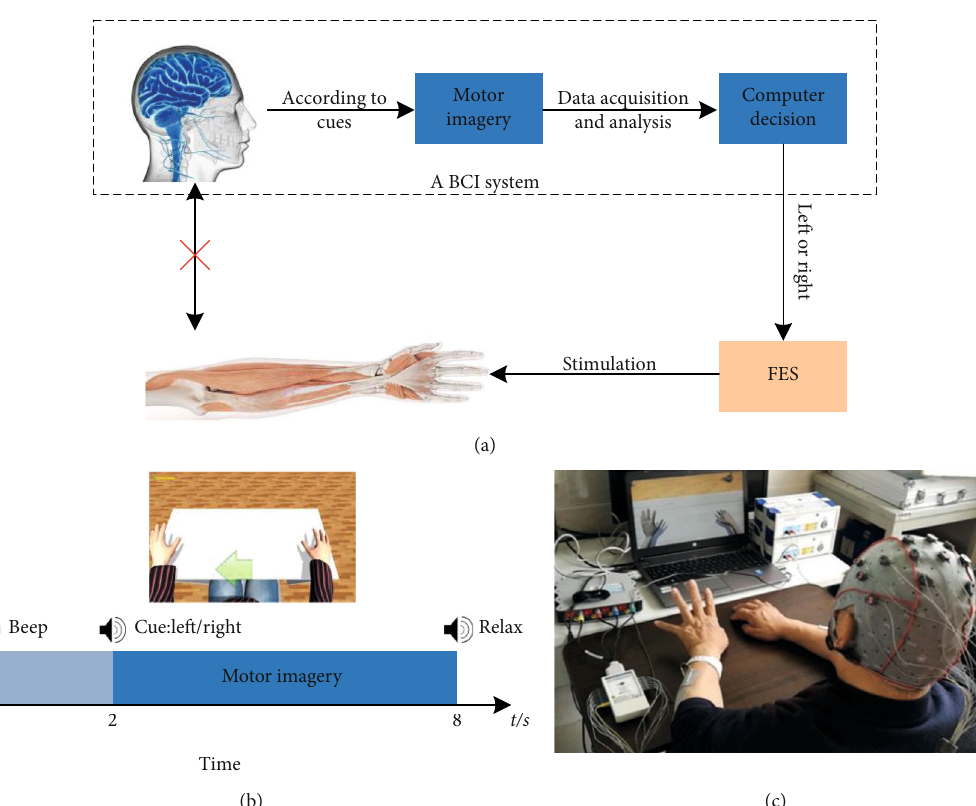
Figure 2: (a) The schematic of the BCI-FES system. (b) The timing of a trial of the motor imagery paradigm. Each trial consisted of task and rest periods. A patient started to execute motor imagery tasks upon the appearance of the cue ( “ left ” or “ right ” ). A virtual avatar of one patient ’ s upper limbs was used to provide virtual reality feedback. (c) This picture shows the scene of BCI-FES rehabilitation training for one